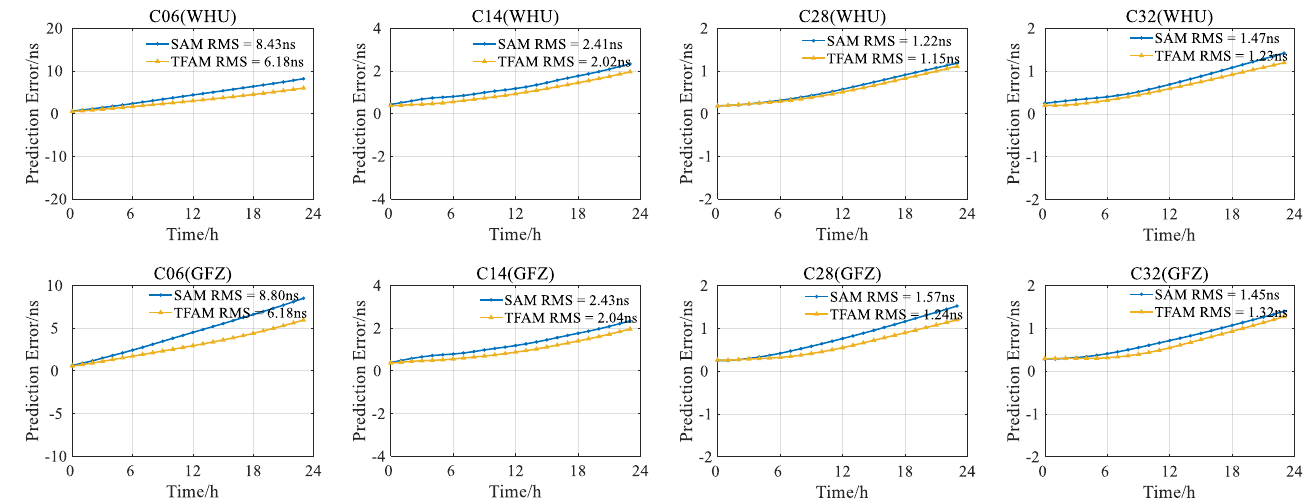
Figure 15. Mean RMS of the SAM and the TFAM prediction errors.